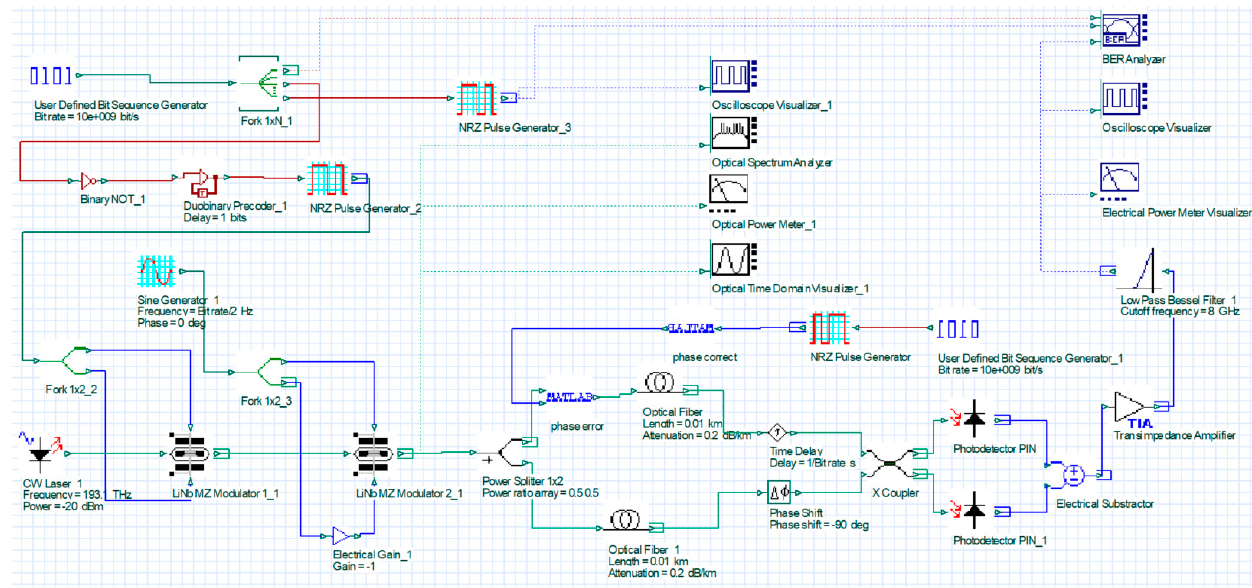
Figure 5. Simulation of an array optical telescope system to compensate phase using balanced detection.